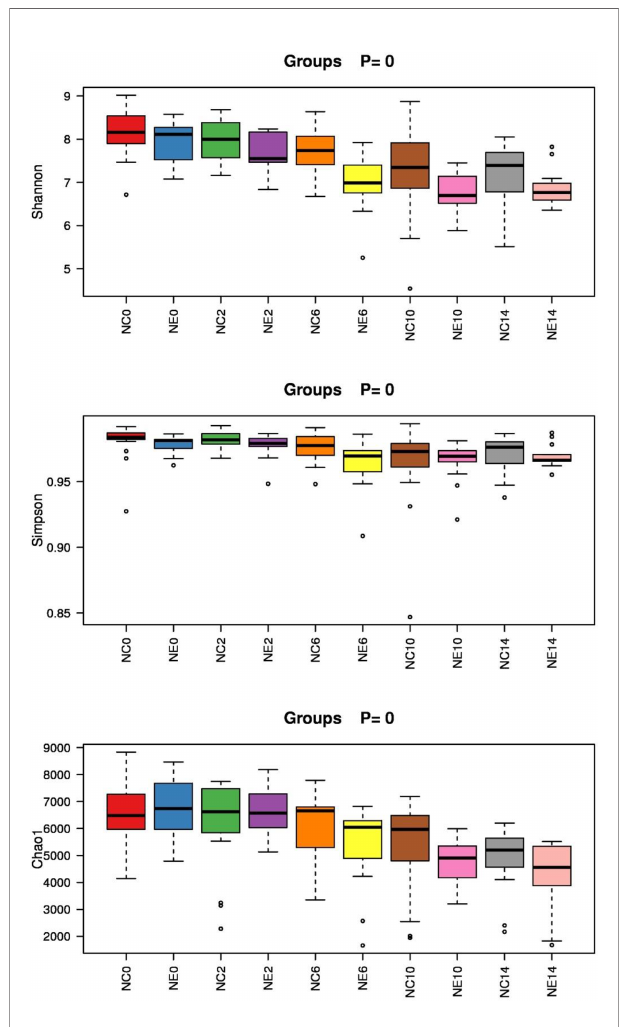
FIGURE 7 | Box diagram of the alpha diversity index of each group of samples. Shannon index, Simpson index, and Chao1 index. The x-axis is the group name, and the y-axis is the value of the alpha diversity index in different groups. The box chart shows fi ve statistics (minimum, fi rst quartile, median, third quartile, and maximum). The abnormal value is marked with an “ o ” , and the top is marked with the p -value (Kruskal-Wallis H-rank sum test). NC = control group; NE = exercise